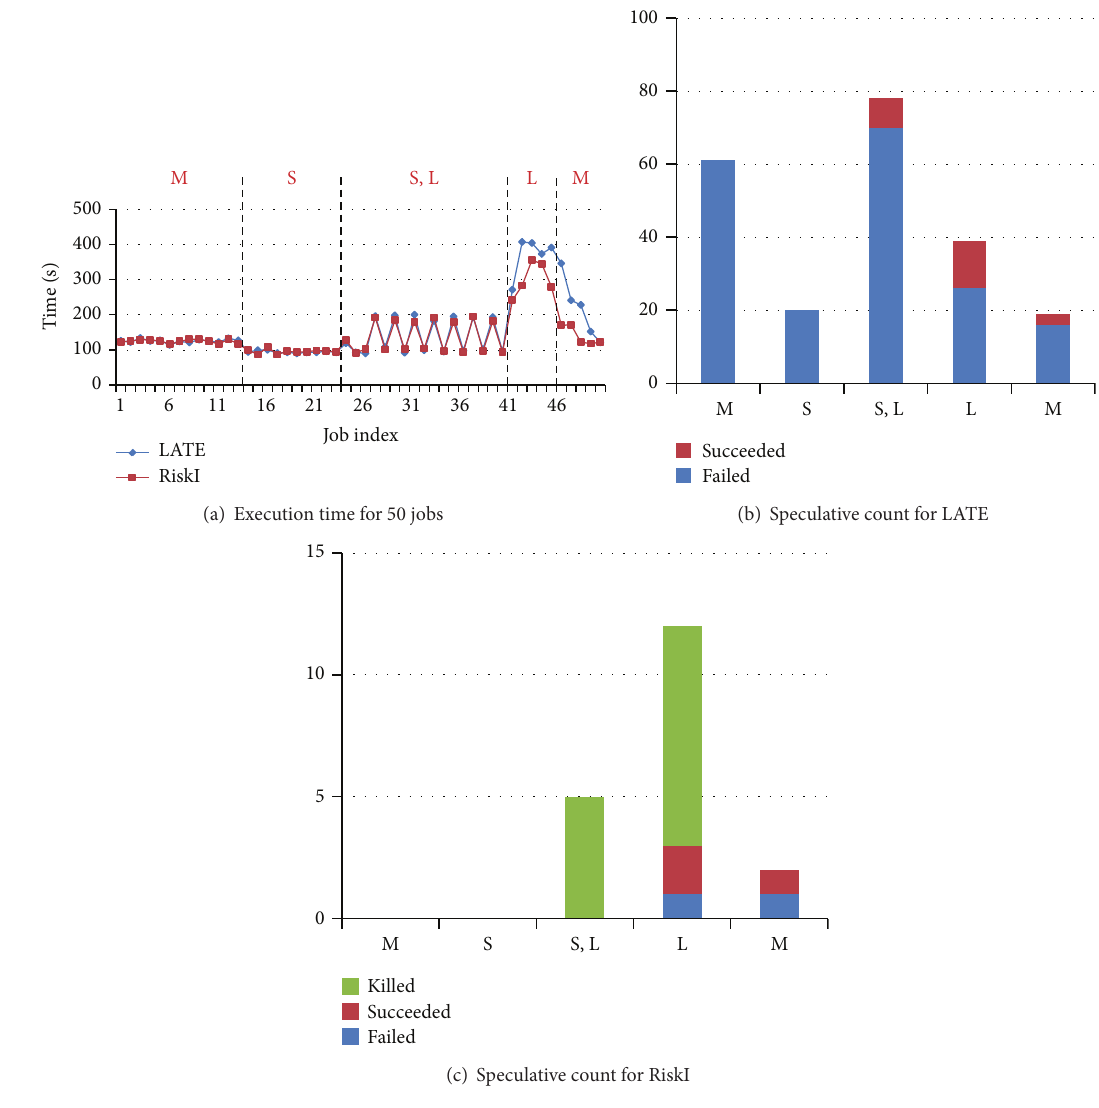
Figure 13: Details of execution information with interval 120. (a) is static of execution time for each job. (b and c) are statistics of speculative execution count in different